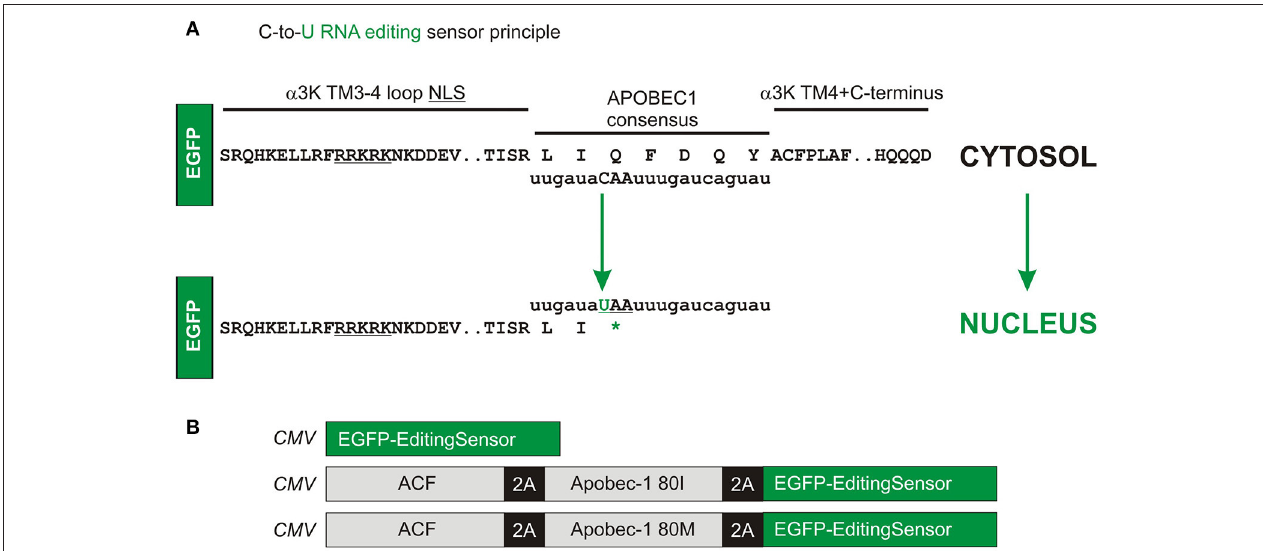
FIGURE 2 | Molecular design of the C-to-U RNA editing sensor. (A) The human Apobec-1 consensus sequence was inserted downstream of EGFP-coding sequence between the C-terminal end of the TM3-4 loop of GlyR α 3K and the GlyR α 3 TM4 domain. Editing of the CAA codon to the STOP codon UAA should result in nuclear targeting of the reporter fluorescence protein (here EGFP). (B) Using the Thosea asigna virus 2A self-processing peptides, additional constructs with human ACF and Apobec-1 (80I or 80M variants) were generated in order to test the efficacy of the editing sensor in response to equimolar multicistronic expression of the corresponding enzyme complex